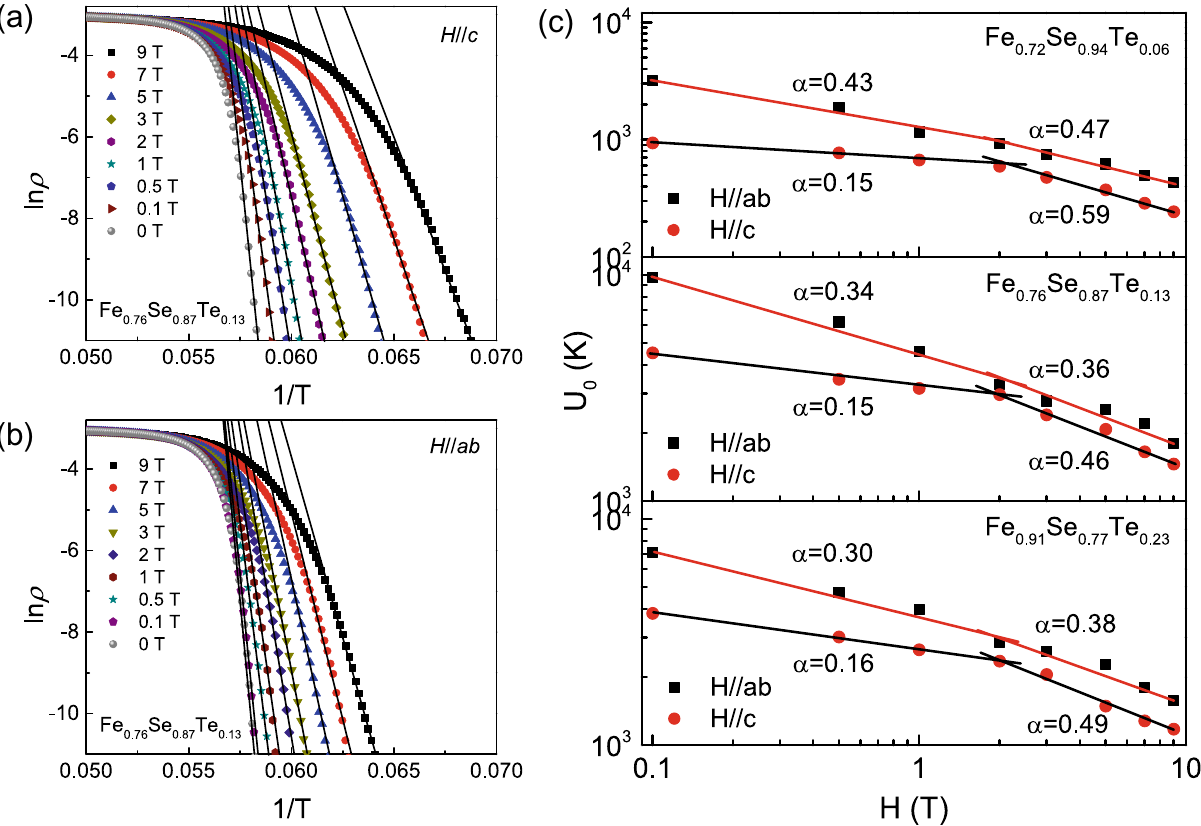
Figure 5. ln ρ versus 1/T curves in various magnetic fields of Fe 0.76 Se 0.87 Te 0.13 thin film. ( a ) H // c ; ( b ) H // ab . ( c ) Magnetic field dependence of the effective flux pinning energy for Fe 0.72 Se 0.94 Te 0.06 , Fe 0.76 Se 0.87 Te 0.13 and Fe 0.91 Se 0.77 Te 0.23 thin films.